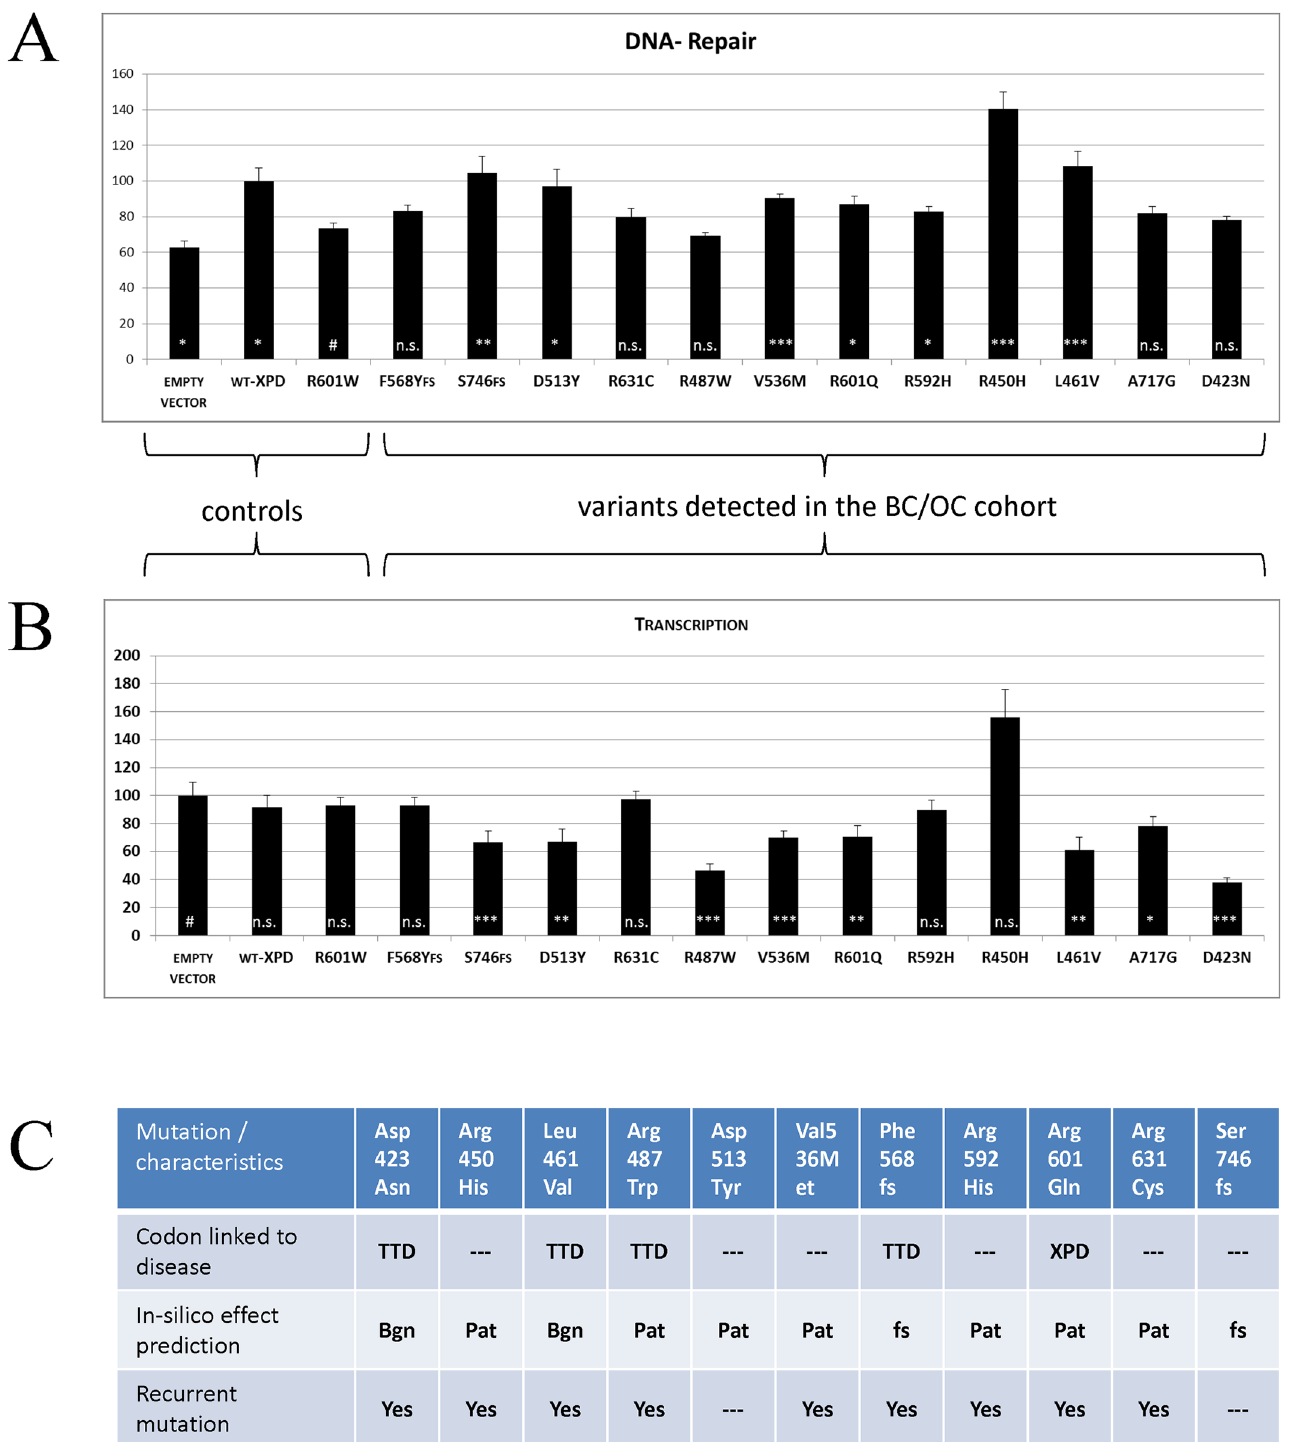
Fig 2. Nucleotide excision repair (NER) capacity and Transcriptional activity of breast cancer associated XPD/ERCC2 variants. (A) Several XPD/ERCC2 variants cloned into an expression vector were analyzed regarding to complementation of ERCC2 -defective XP6BE cells overexpressing the NER-deficient R601W XPD mutant [15] (normalization for overexpression artifacts). Black bars indicate the mean relative repair capacity (in %, WT-XPD was set to 100%) of an UV irradiated firefly luciferase reporter gene plasmid (UVC 1000 J/m 2 ) obtained by host cell reactivation (n > 6 in triplicates). Red lines mark the range between DNA-repair levels of empty vector, i.e. residual repair activity of the cells,